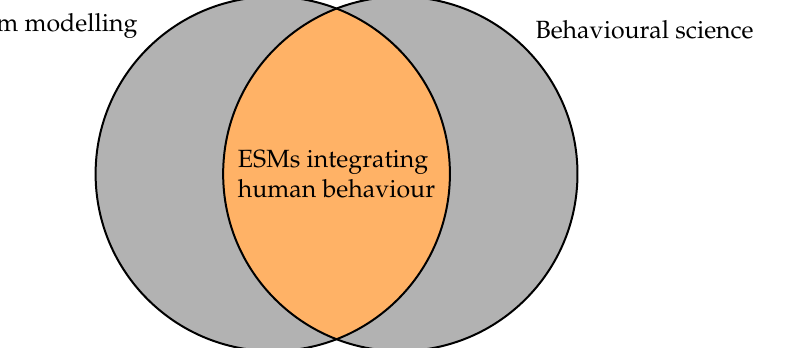
Figure 3. Hypothesised intersection of the disciplines of energy system modelling and be- havioural